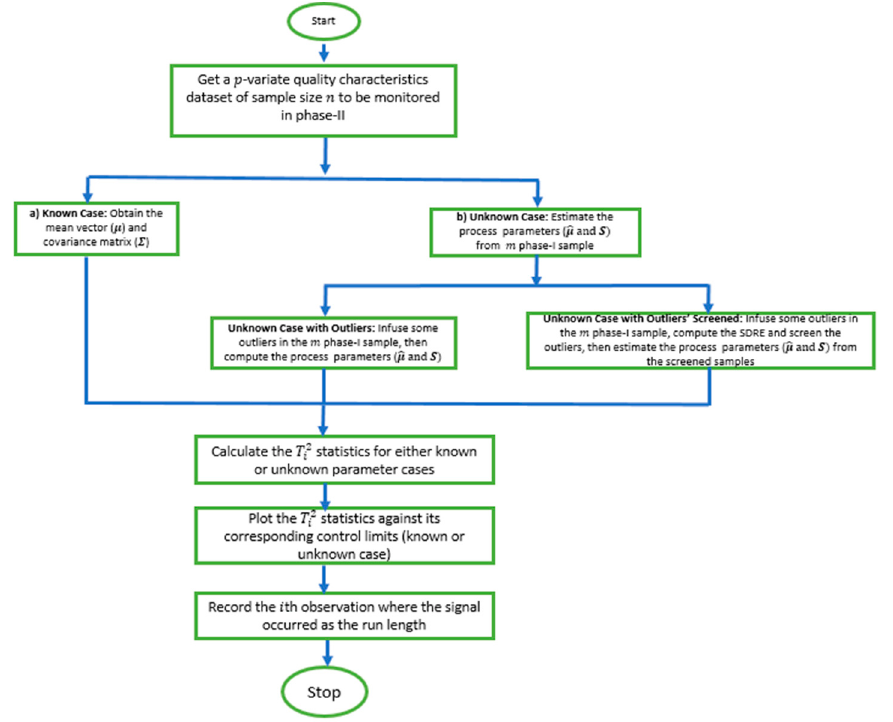
Figure 1. The flowchart of the methodology.